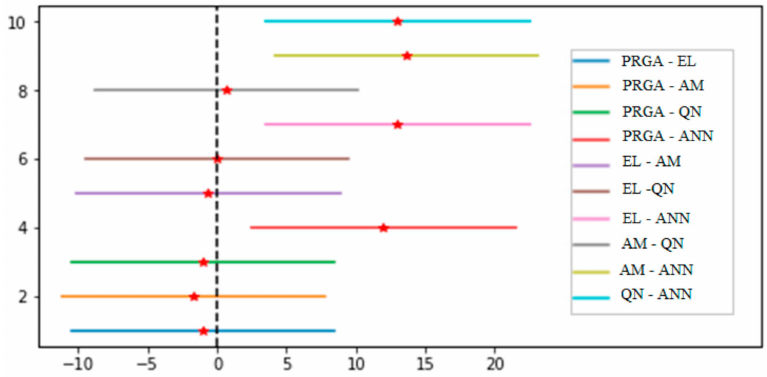
Figure 18. Tukey’s test: real